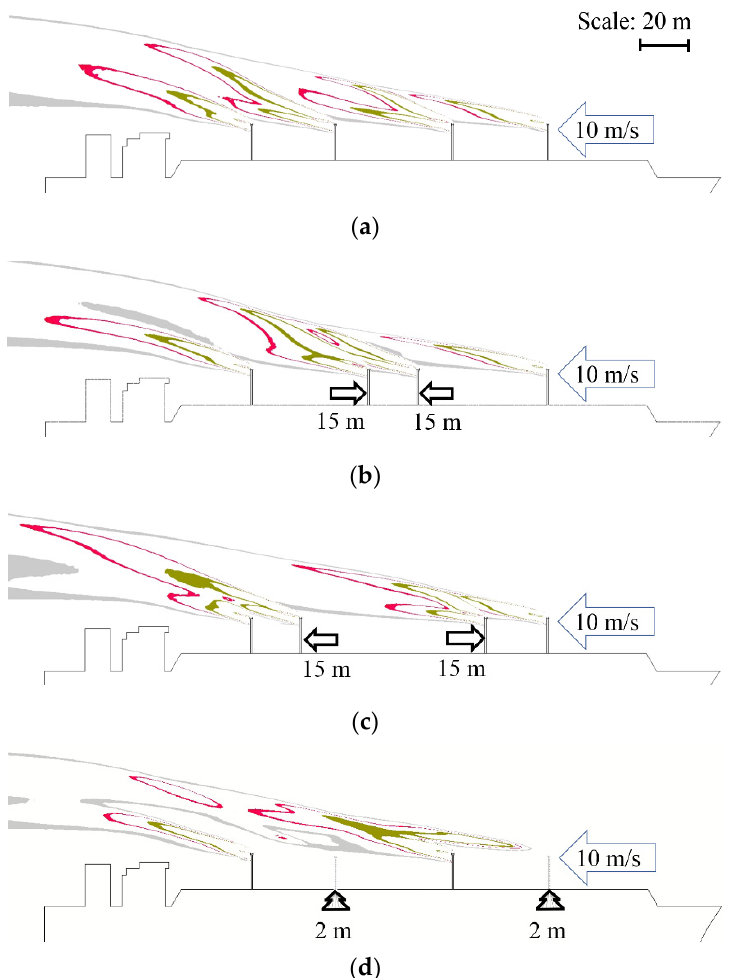
Figure 6. Contour lines of the FL on the cross section of the vent-mast line as a criterion at a relative wind speed of 10 m/s: Based on the arrangements of ( a ) reference; ( b ) 1–23–4; ( c ) 12–34; and ( d ) zigzag.